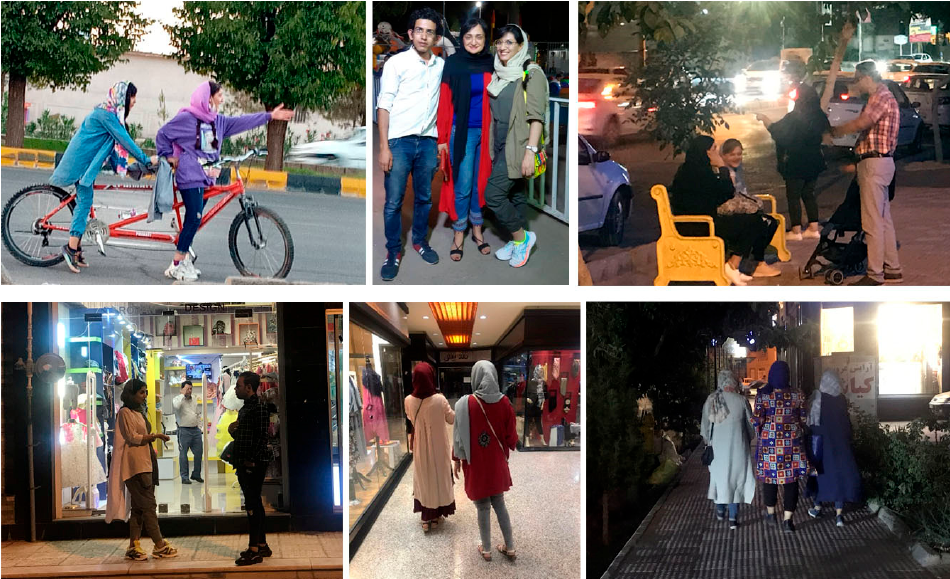
Figure 8. The existing behaviors in urban public space in modern neighborhoods. (Source author).